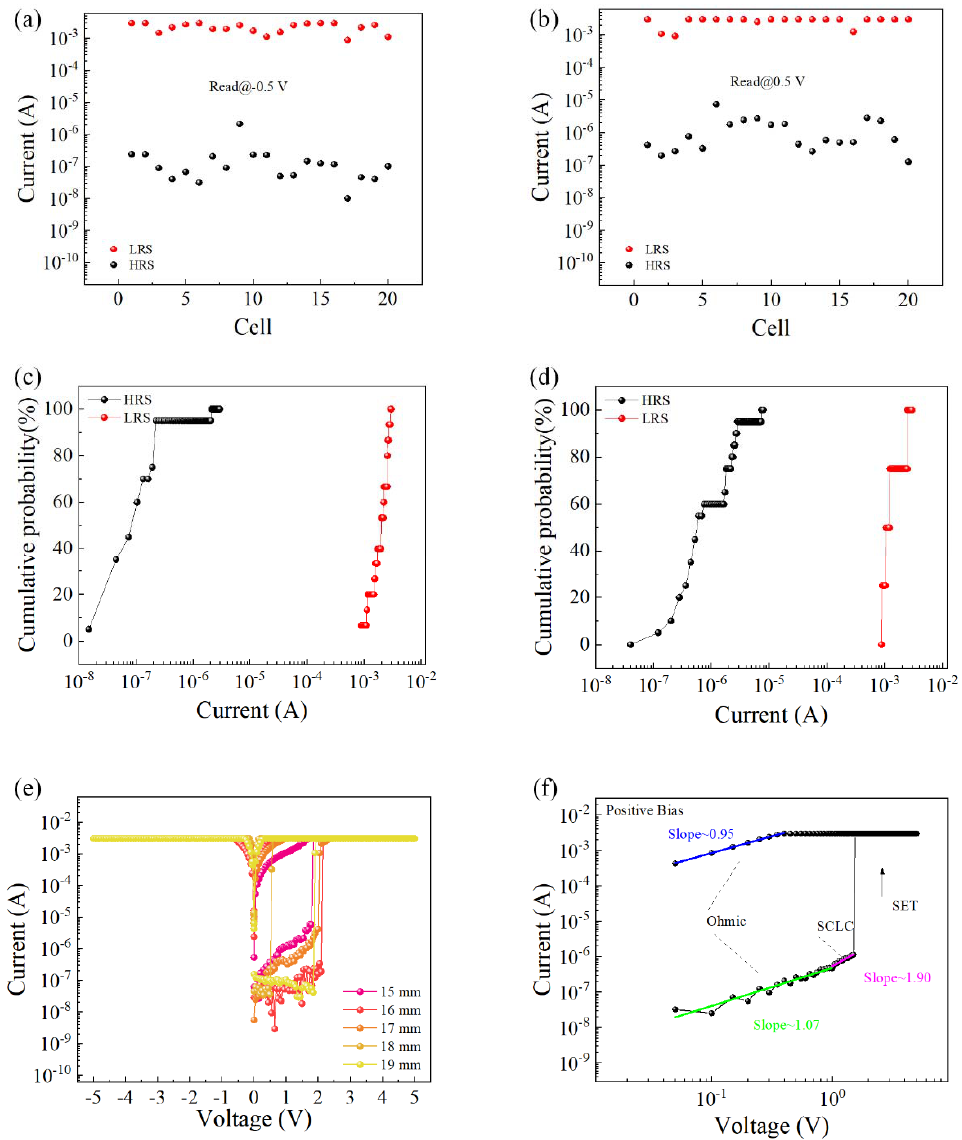
Figure 3. High and low resistance values of Al/EA:GQD/ITO devices. ( a ) Initially applied negative voltage. ( b ) Initially applied positive voltage. ( c ) Cumulative probability of initial negative voltage application. ( d ) Cumulative probability of initial positive voltage application. ( e ) I–V characteristic curves of different bending degrees. ( f ) Double logarithmic curve.